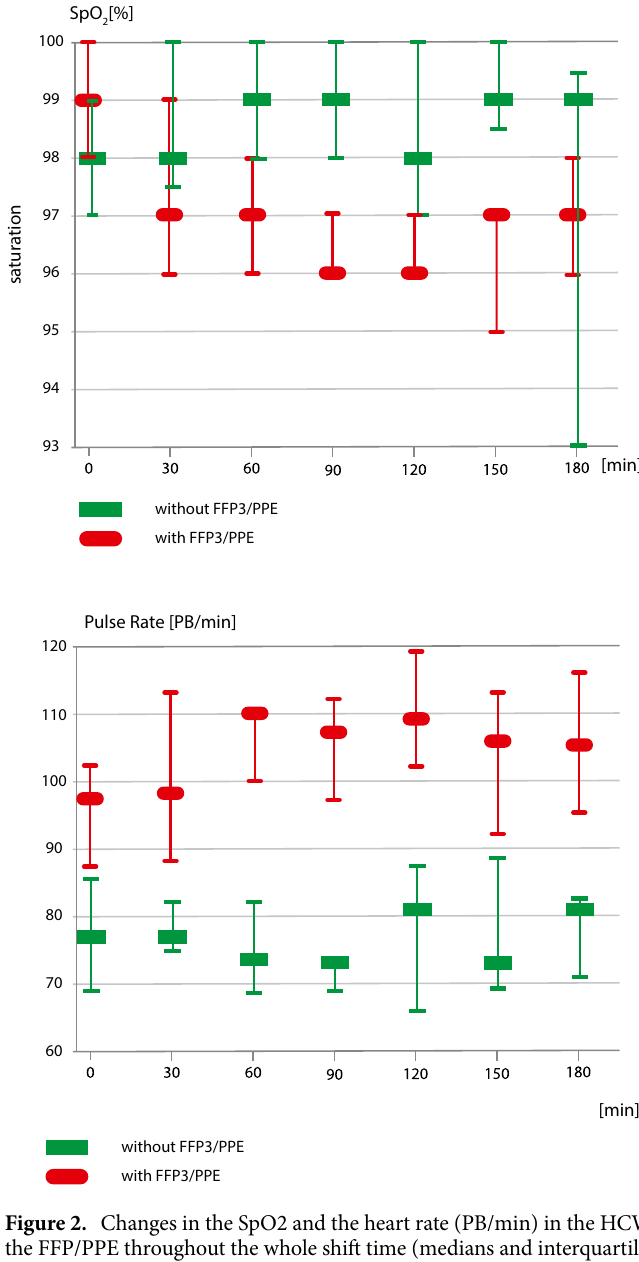
Figure 2. Changes in the SpO2 and the heart rate (PB/min) in the HCWs working in the FFP/PPE and without the FFP/PPE throughout the whole shift time (medians and interquartile range are